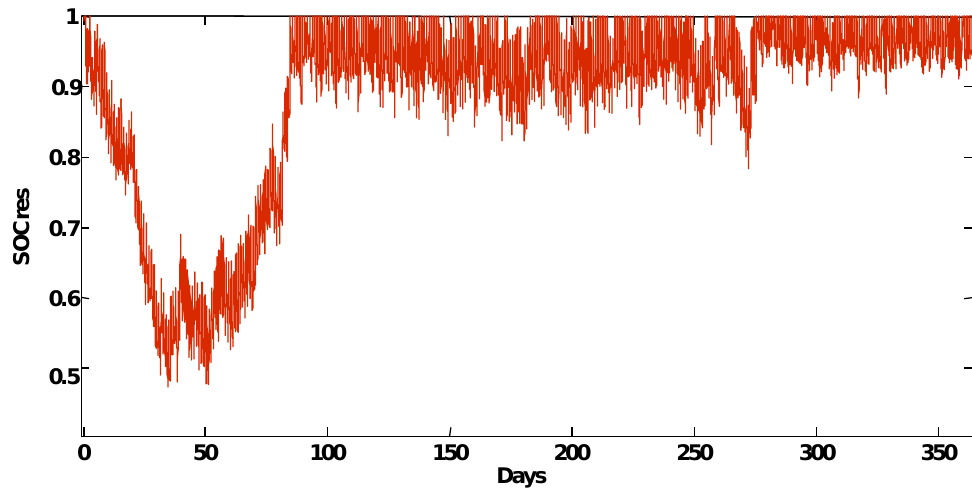
Figure 20. State of charge of the tank.